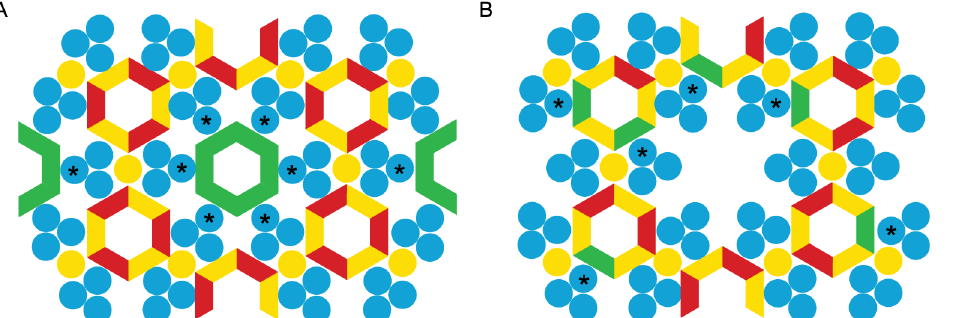
Fig 7. Schematic models of possible integration of CheV into the chemoreceptor array. Top-view of the arrangement of the array components showing the known and proposed interaction sites between chemoreceptor trimers (blue), CheA (yellow) and CheW (red) [36, 37], as well as potential locations of CheV (green). Chemoreceptors that interact with CheV are marked with asterisks. A) CheV occupies the proposed empty ring and does not interact with CheA P5 or CheW. B) CheV might be incorporated with CheW and CheA P5 into the hexagonal